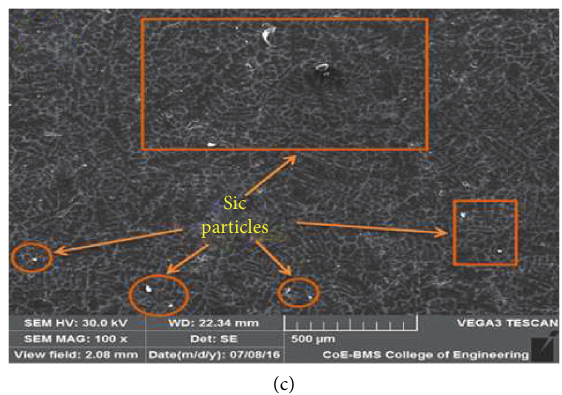
Figure 9: SEM images of (a) Al6351/4 wt% SiC AMCs, (b) Al6351/8 wt% SiC AMCs, and (c) Al6351/12 wt% SiC AMCs [18].